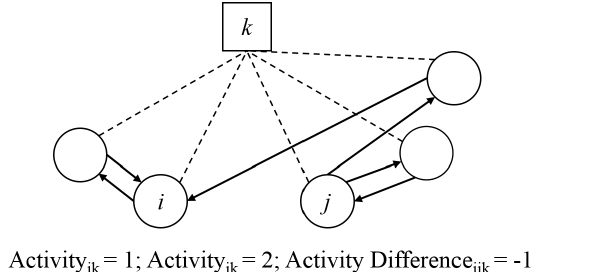
Fig. 2 . Illustration of differences in activity and popularity between actors participating in a policy forum. Actors are depicted as circles and forums as squares. Participation in forums is indicated by dashed lines and outgoing/incoming collaborative relationships are represented as solid